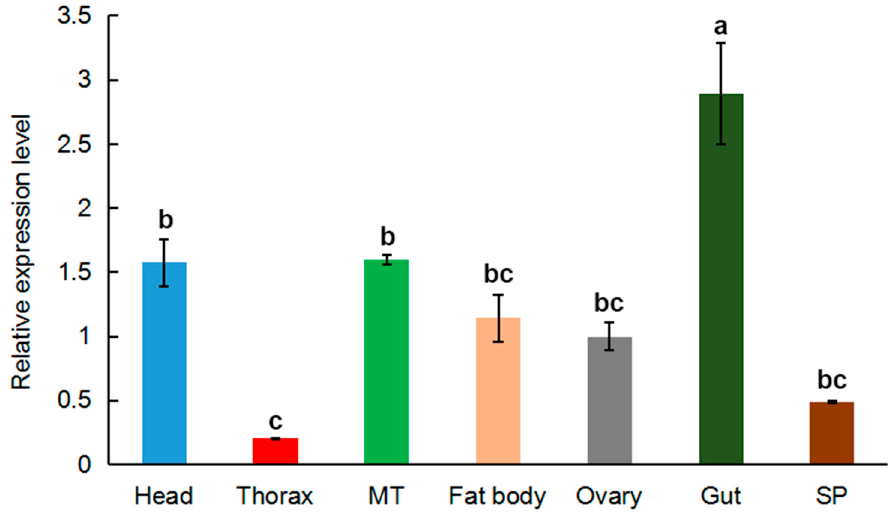
Figure 3. The relative expression of MRLC-sqh in the tissues of adult O. communa . The expression fold changes were related to the ovary. The transcript level of MRLC-sqh was normalized against that of ribosomal protein L4 ( RPL4) . Relative expression is represented as mean ± SE. Abbreviations: MT, Malpighian tubule; SP, spermaries. Bars with different lowercase letters are significantly different at p < 0.05.